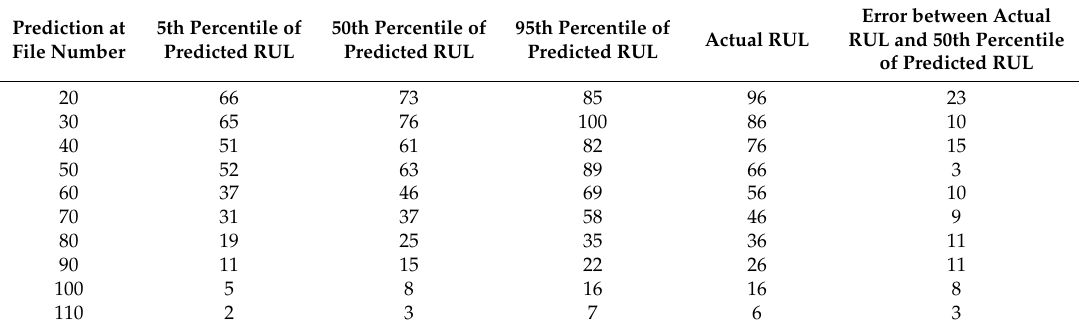
Table 3. The predictions of the RUL by replacing the unscented particle filtering with the standard particle filtering in our proposed prognostic method (Unit: measurement